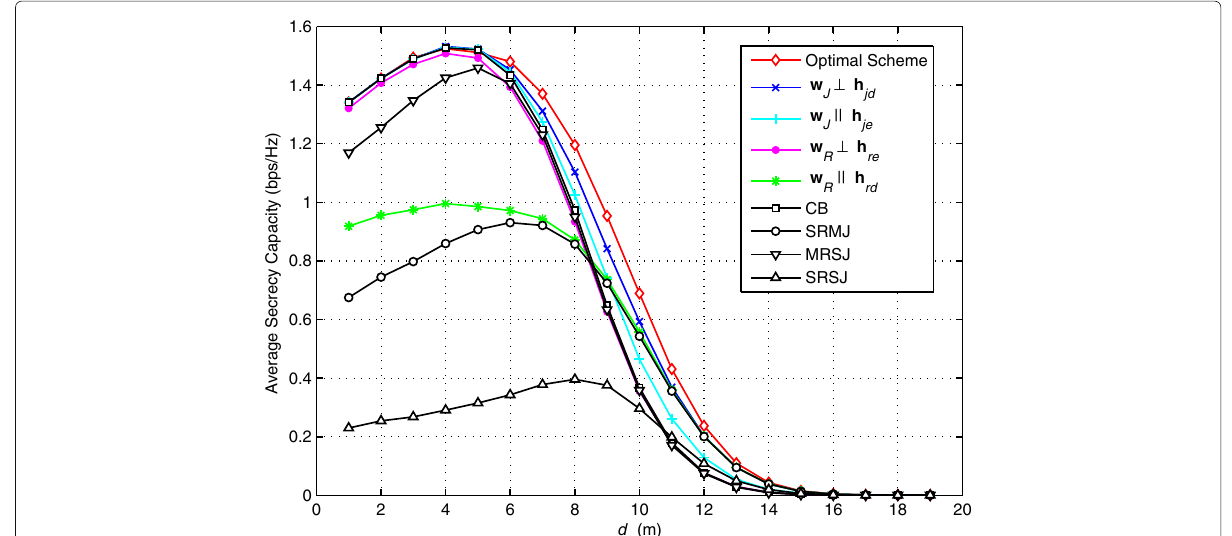
Fig. 5 The average secrecy capacity versus the distance from source to relays ( d sr ), P t = 10 dB, N =